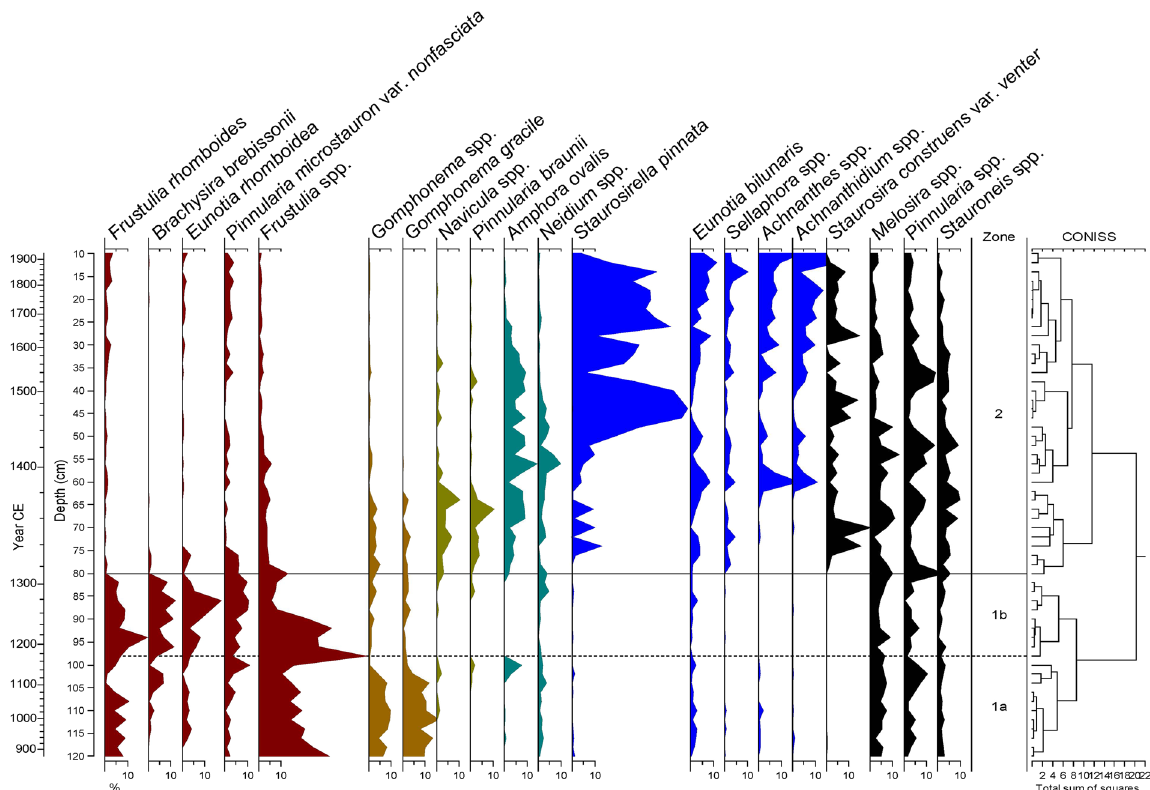
Figure 2. Selected diatom taxa from Mulyoungari sediments. Diatom taxa are assigned with different color shades according to their trophic preference. Diatoms in dark red, mocha, olive, teal, and blue likely prefer oligotrophic, less oligotrophic, mesotrophic, eutrophic, and more eutrophic conditions,